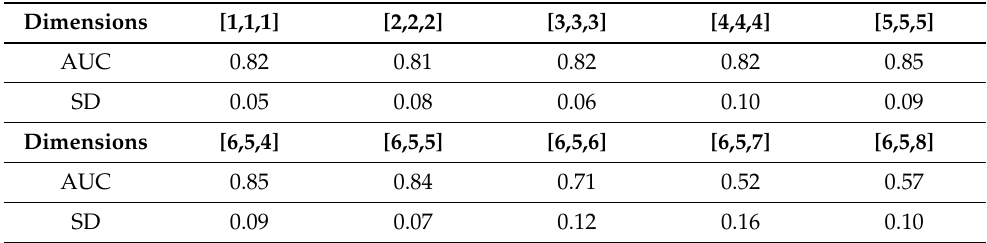
Table 7. Performance (mean AUC and standard deviation) of ManTDA on tensors from the PTB dataset as the dimensions [ I , J , K ] increase (10 iterations).